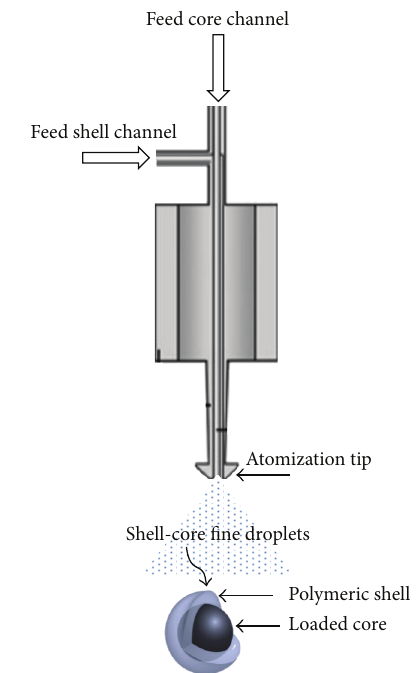
Figure 1: Sketch of the dual liquid feed ultrasonic atomizer